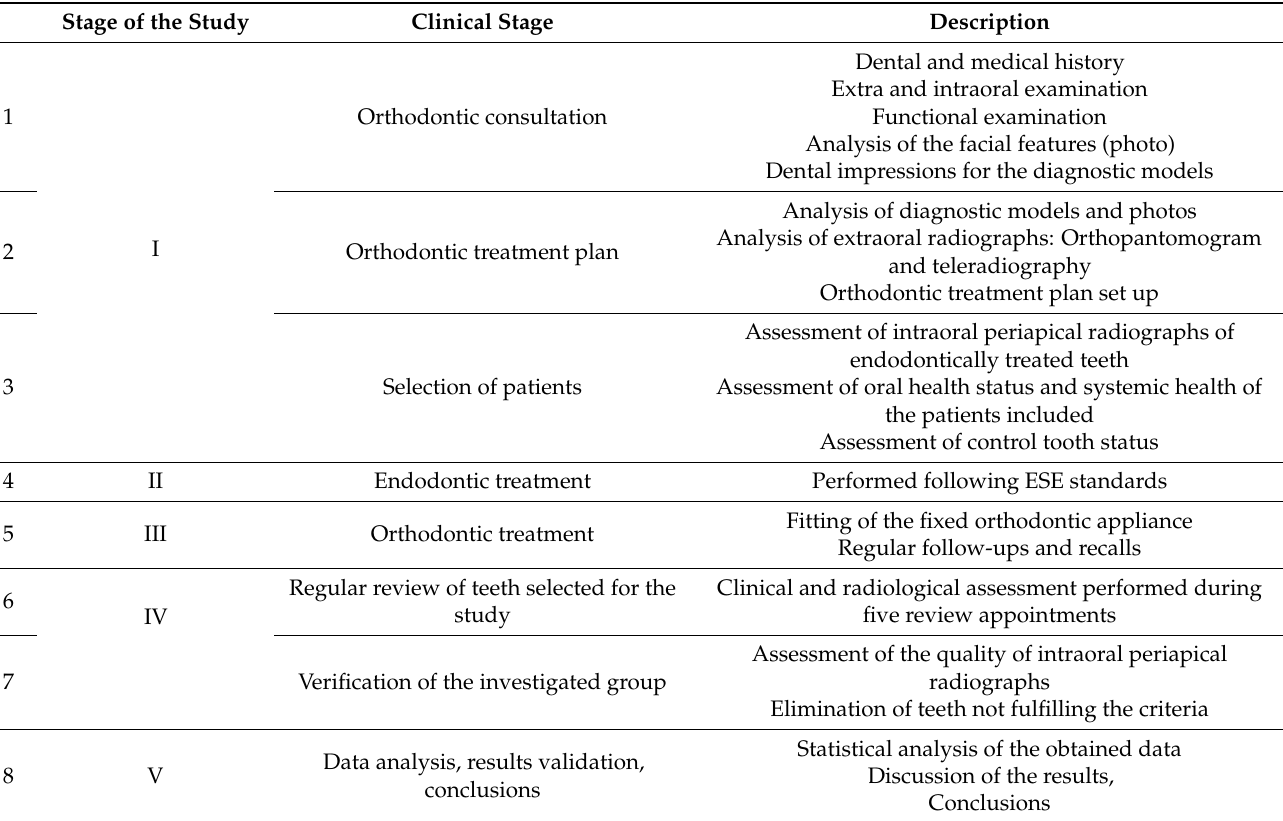
Table 2. Clinical stages of orthodontic protocol and